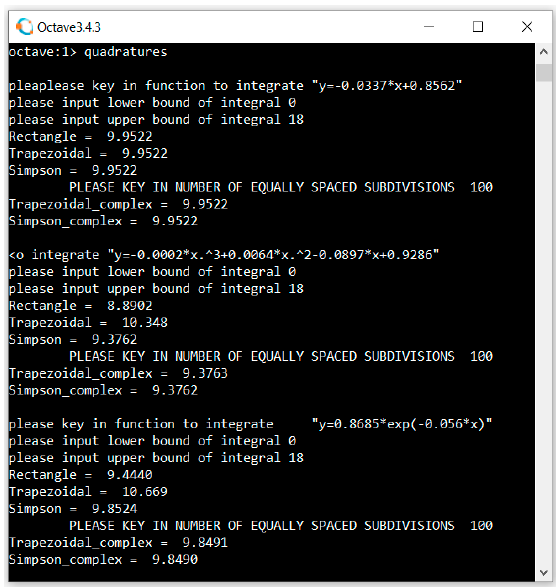
Figure 4. Result of Octave 3.4.3 software operations.